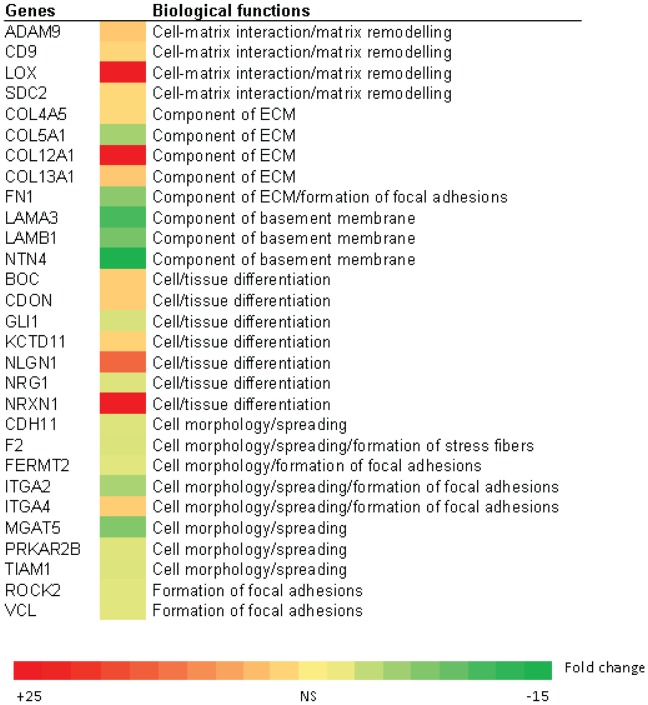
Heat map of gene expression level comparing untreated 3D cultures to 2D cultures (3D+EtOHvs2D+EtOH).The fold change in expression levels of genes related to cellular functions are represented by the colors in the heatmap. The green color denotes a decrease in expression in 3D cultures relative to 2D cultures and the red color denotes an increase in 3D cultures relative to 2D cultures. The fold change between −1.5 to +1.5 is considered not significant (NS). The differential expression of these molecules suggests that LNCaP cells grown in 3D may assume different roles in cell-cell signaling and interactions from the 2D cultures.